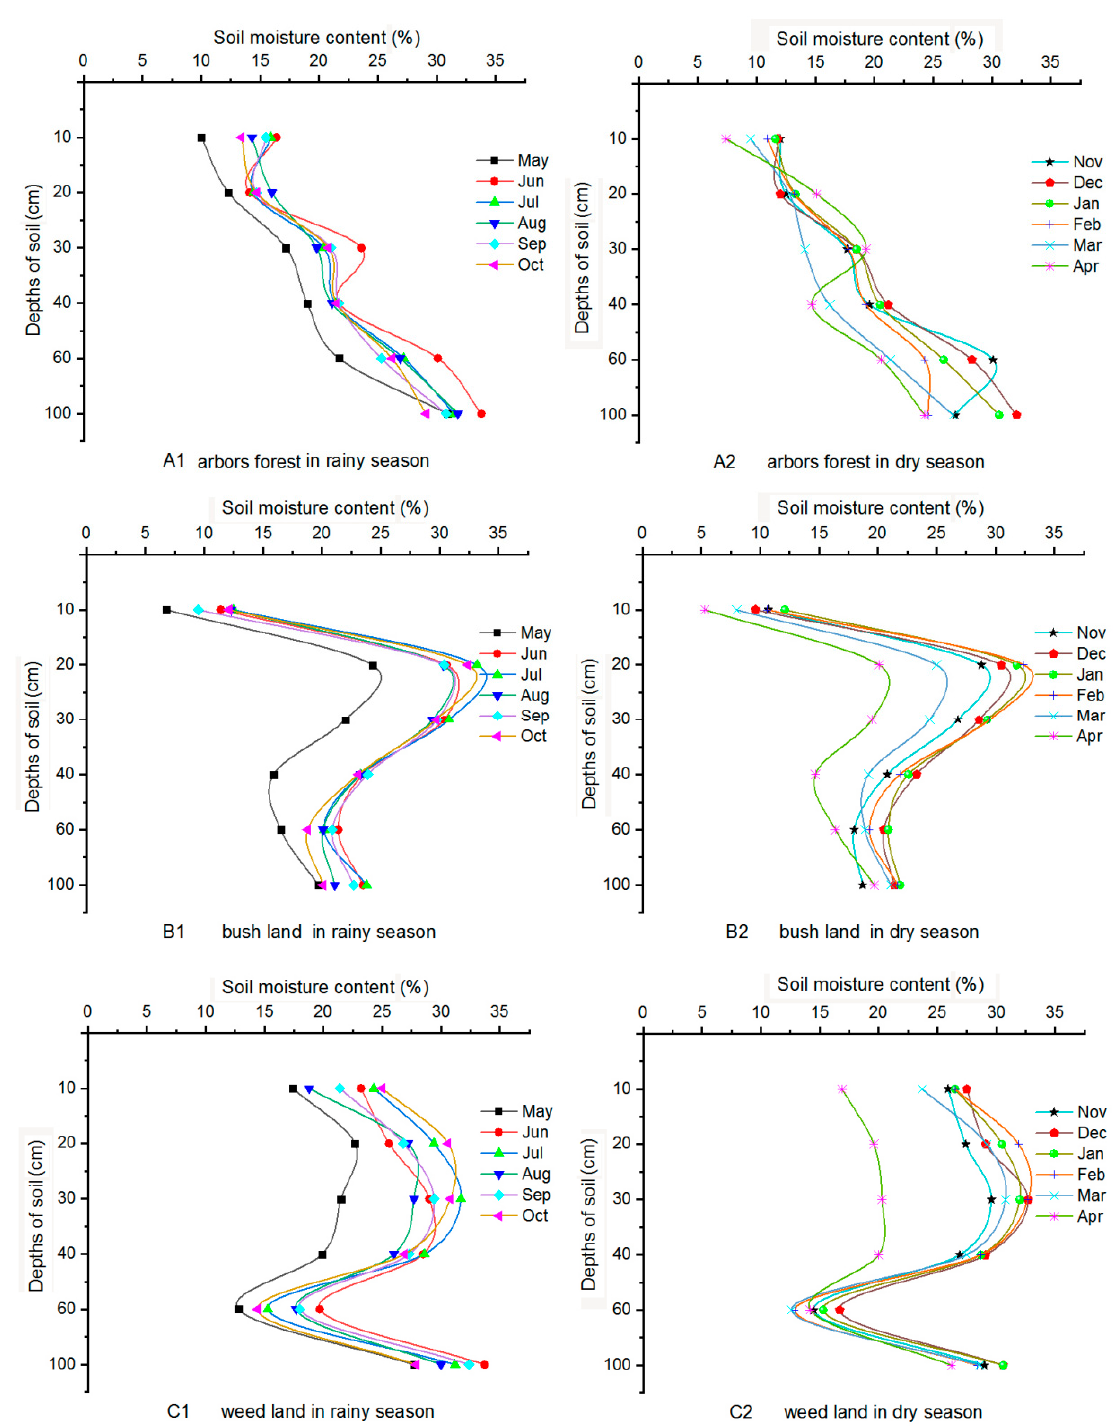
Figure 7. The variation of soil moisture content in the rainy and dry seasons in different soil.